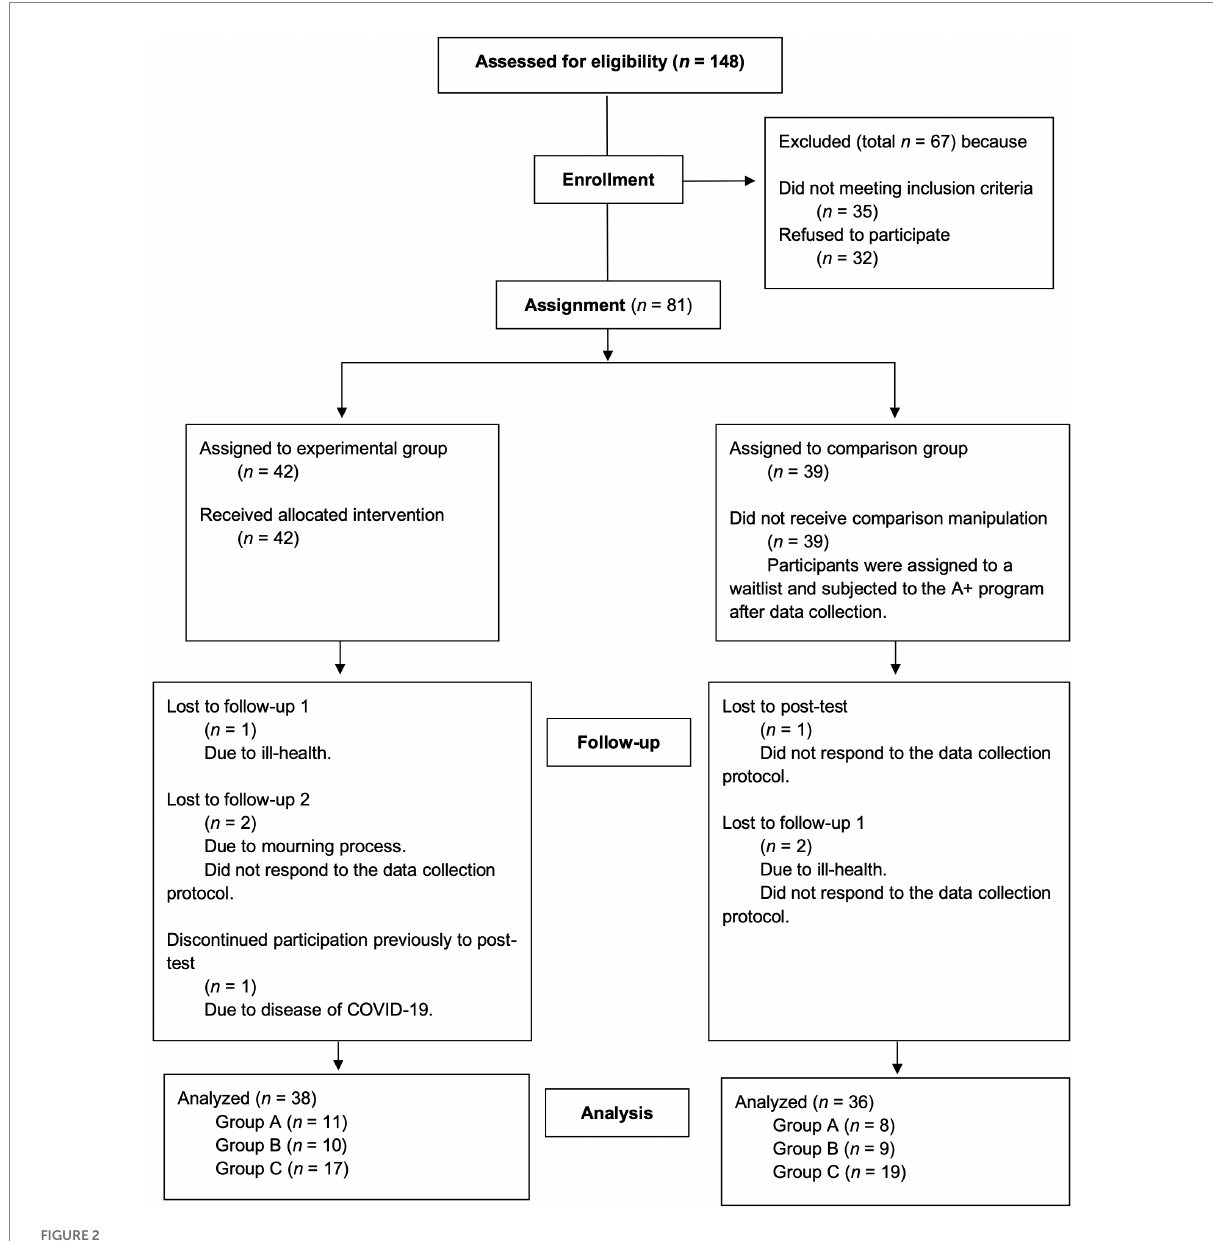
FIGURE 2 CONSORT